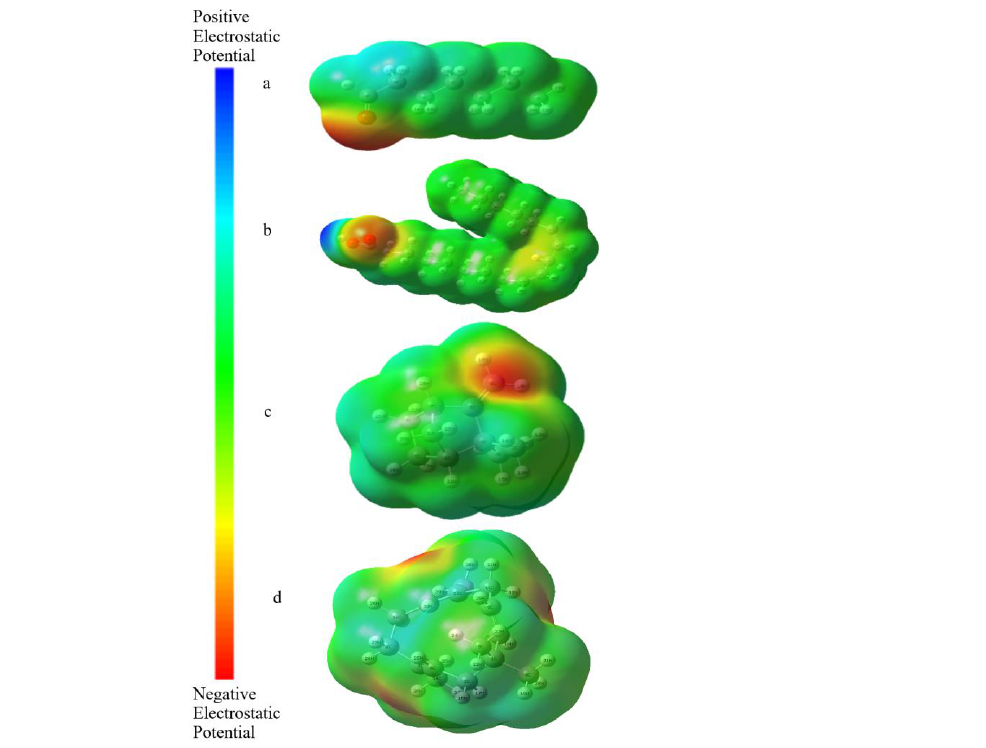
Figure 4. Three-dimensional MEP surface maps of the studied molecules ( a – d ).